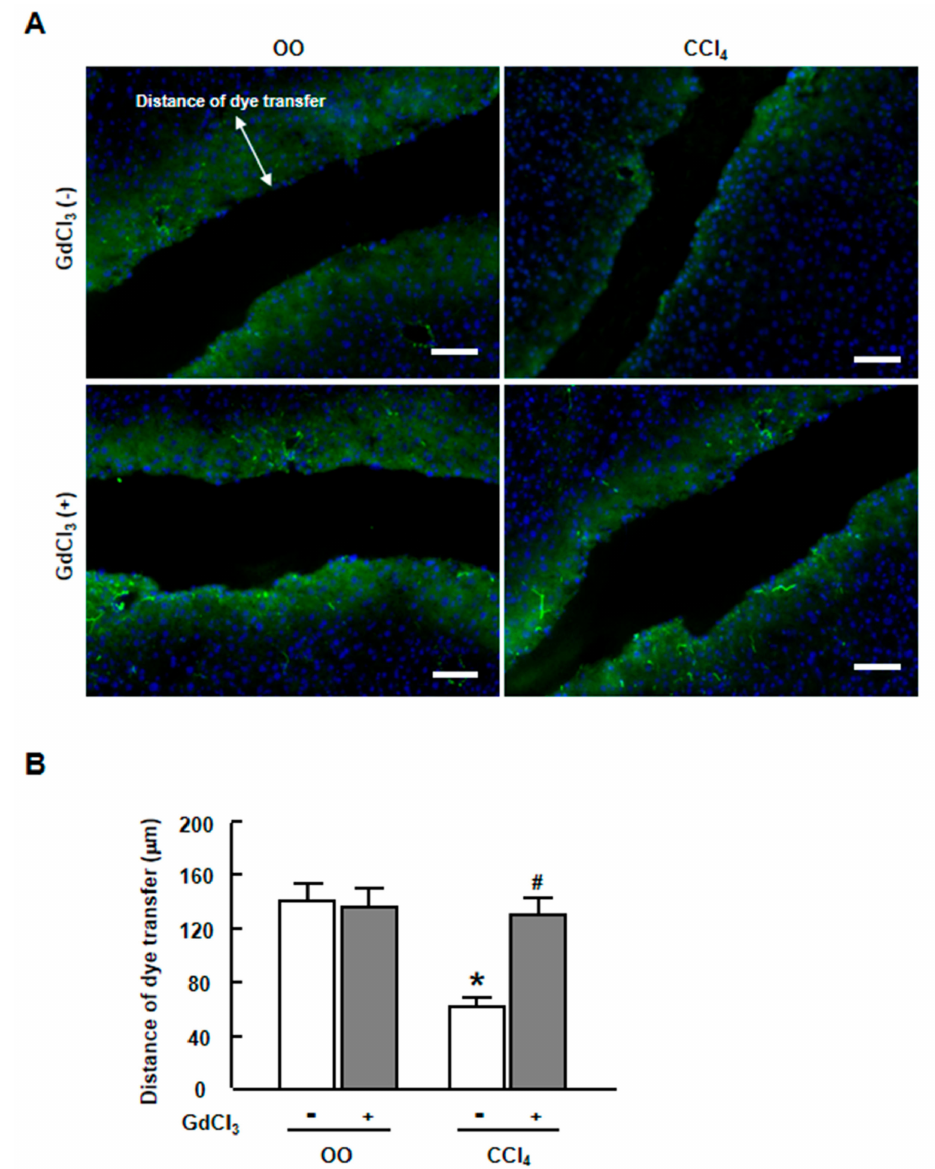
Figure 3. The gap junctional intercellular communication (GJIC) function in CCl 4 -treated mice with or without GdCl 3 administration. ( A ) Digital images of Lucifer yellow dye transfer in liver treated with OO, CCl 4 , GdCl 3 plus OO, GdCl 3 plus CCl 4 . Scale bars, 100 µ m. ( B ) GJIC function and integrity was determined by quantifying the distance of the Lucifer yellow dye transfer from the incision. Data are presented as the mean ± SEM and were analyzed by ANOVA for the analysis of variance. * p < 0.05 vs . OO-treated mice. # p < 0.05 vs . CCl 4 -treated mice without GdCl 3 administration. Immunofluorescent staining for gap junction proteins, Cx32 and Cx26, was performed in primary hepatocytes to assess the e ff ect of GdCl 3 on connexins in vitro. Isolated hepatocytes showed a strong expression of Cx32 (Figure 6A) and Cx26 (Figure 6B) on the hepatocyte membrane under normal conditions. DiOC18, a membrane dye, was used to label this hepatocyte membrane to make sure the red stained spots of Cx32 (Figure 6A) and Cx26 (Figure 6B) were mostly placed onto the membrane surface. Importantly, the treatment of CCl 4 resulted in the impairment of Cx32 and Cx26 plaques, which can be distinctly recovered by the administration of GdCl 3 (Figure 6A,B). These results indicated that GdCl 3 protected against the down-regulation of connexins and restored the Cx32 / Cx26 plaques between hepatocytes in